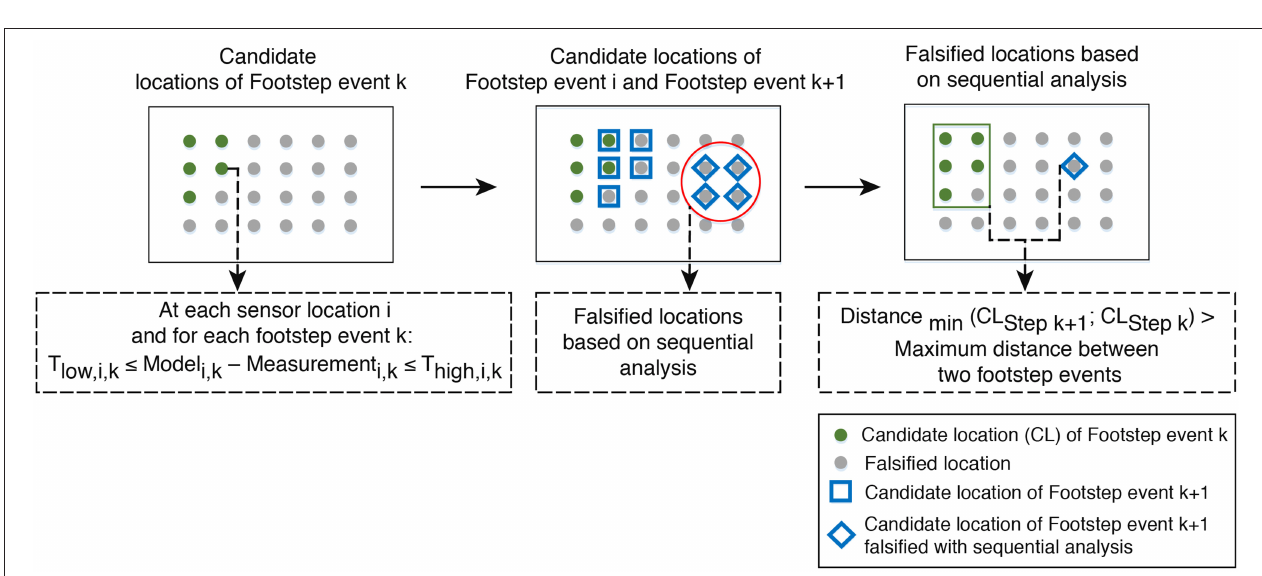
FIGURE 3 | Sequential analysis is applied for each candidate location set of each footstep event resulting from EDMF. Based on information from the previous footstep event, sequential analysis reduces the population of the resulting candidate locations.